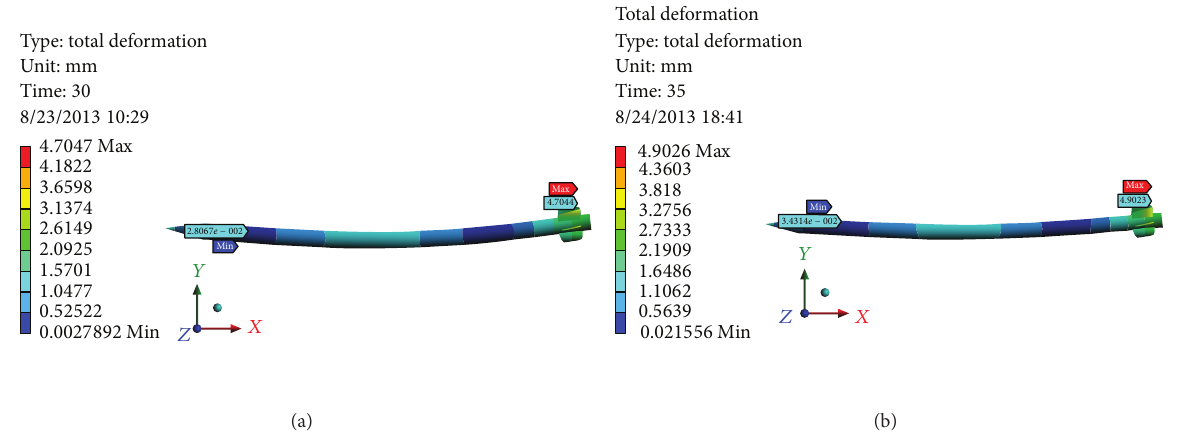
Type: total deformation